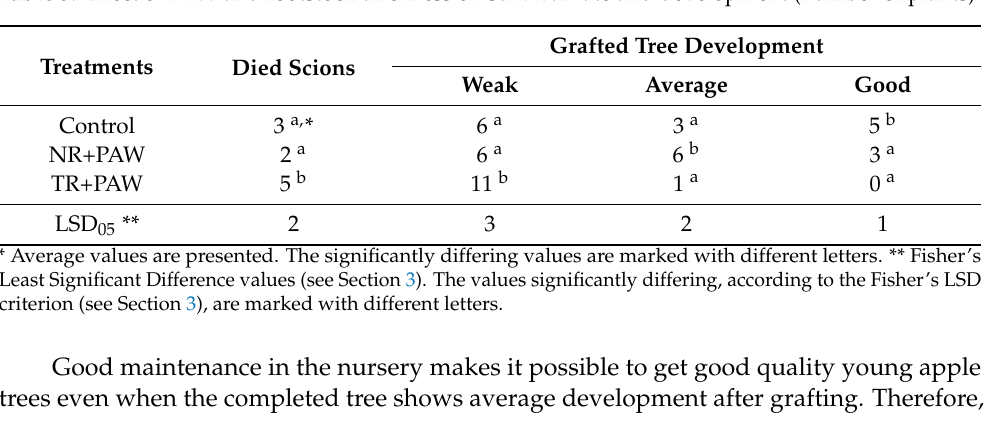
Table 5. Effect of PAW and rootstock thickness on survival rate and development (number of